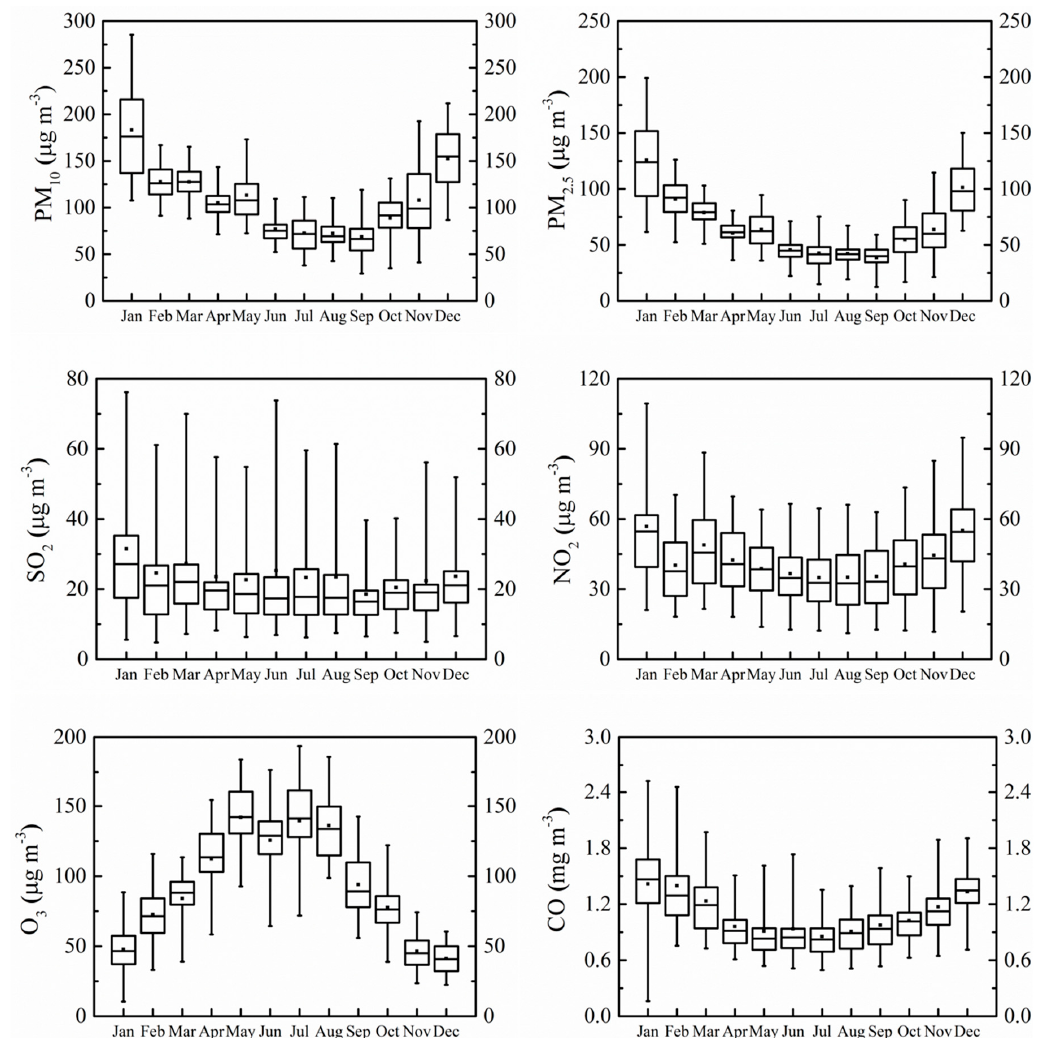
Figure 5. Monthly variations in PM 10 , PM 2.5 , SO 2 , NO 2 , O 3 , and CO. The horizontal solid lines indicate the median and the filled squares indicate the mean, and range where the top and bottom of the box indicate the 75th and 25th percentiles, respectively. The top and bottom whiskers indicated the maximum and minimum values, respectively.